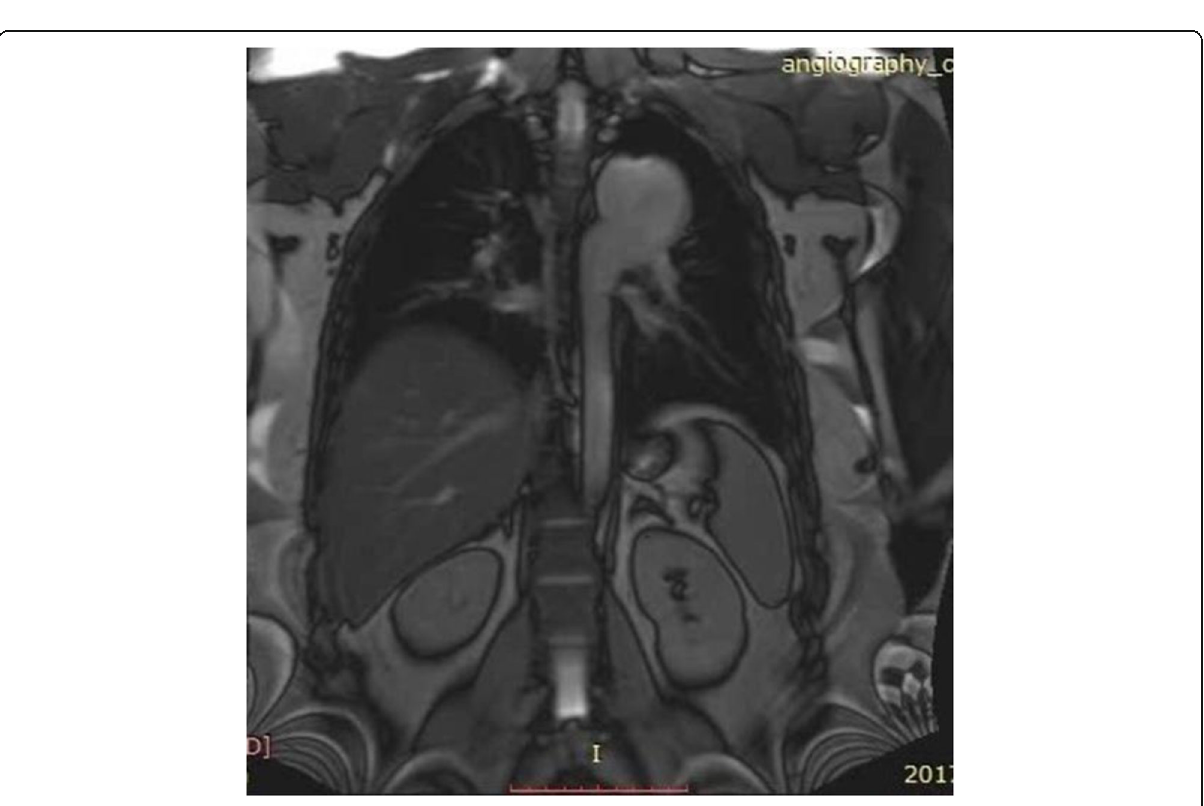
Fig. 2 Cardiac magnetic resonance images showing aneurysmal dilation in distal part of aortic arch and proximal part of descending aorta (maximum diameter of 50